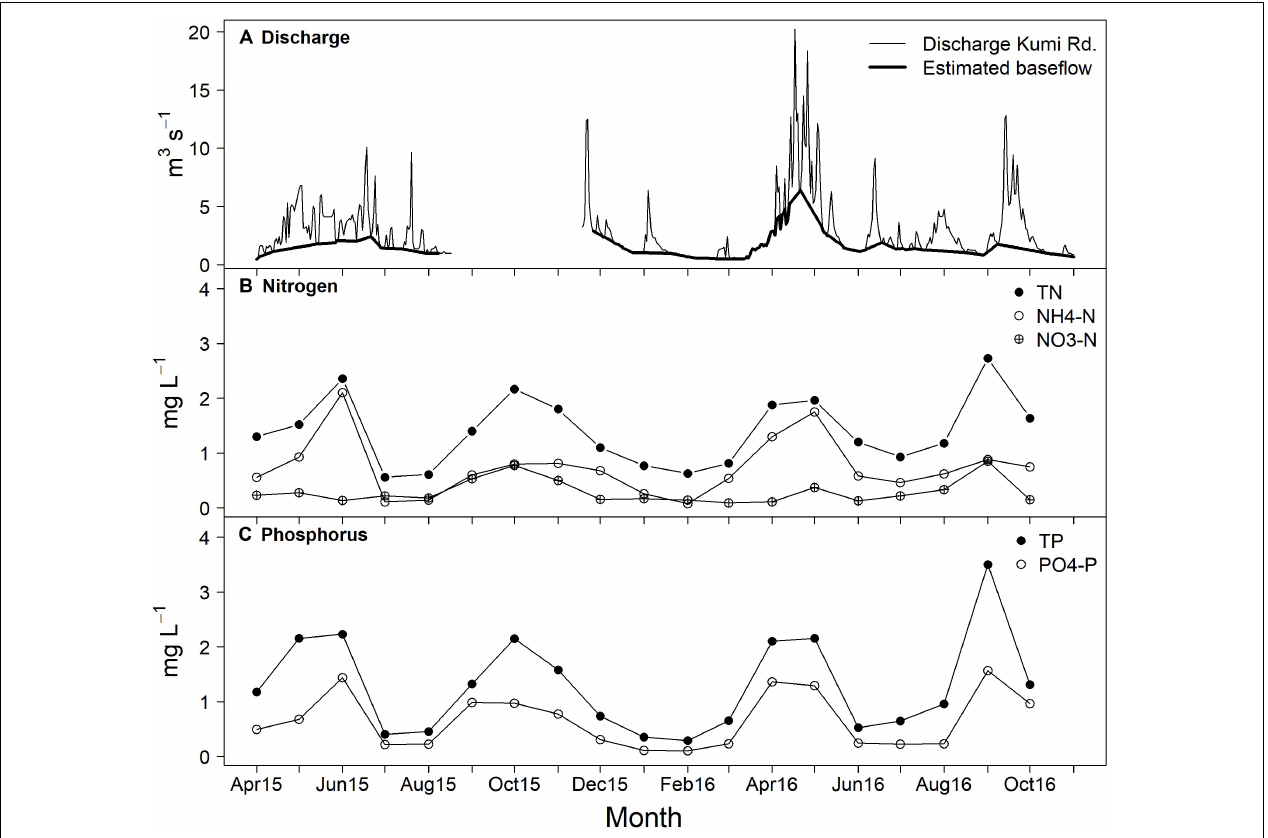
FIGURE 6 | (A) Separation of baseflow for the Namatala River; (B) nitrogen concentration; and (C) phosphorus concentration; all at Kumi Road, Mbale, during the experimental period. Daily discharge data from the gauge at Kumi Road were used from the period 2000–2015 using the method from WMO (2008). Estimated Base Flow Index (BFI) for Namatala River was 0.605. Owing to a technical problem at the gauging station, there was a gap in discharge data in the period August–November 2015. For further explanation, see